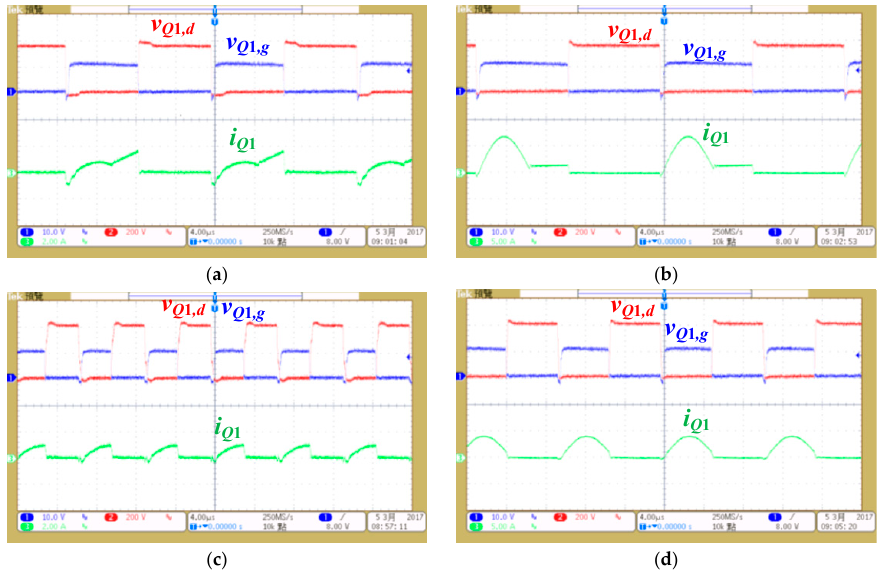
Figure 9. Test results of Q 1 under ( a ) V H = 350 V and 20% load [ v Q 1 ,g : 10 V/div; v Q 1 ,d : 200 V/div; i Q 1 : 2 A/div; time: 4 µ s/div] ( b ) V H = 350 V and 100% load [ v Q1,g : 10 V/div; v Q 1 ,d : 200 V/div; i Q 1 : 5 A/div; time: 4 µ s/div] ( c ) V H = 400 V and 20% load [ v Q 1 ,g : 10 V/div; v Q1,d : 200 V/div; i Q 1 : 2 A/div; time: 4 µ s/div] ( d ) V H = 400 V and 100% load [ v Q 1 ,g : 10 V/div; v Q 1 ,d : 200 V/div; i Q 1 : 5 A/div; time: 4 µ